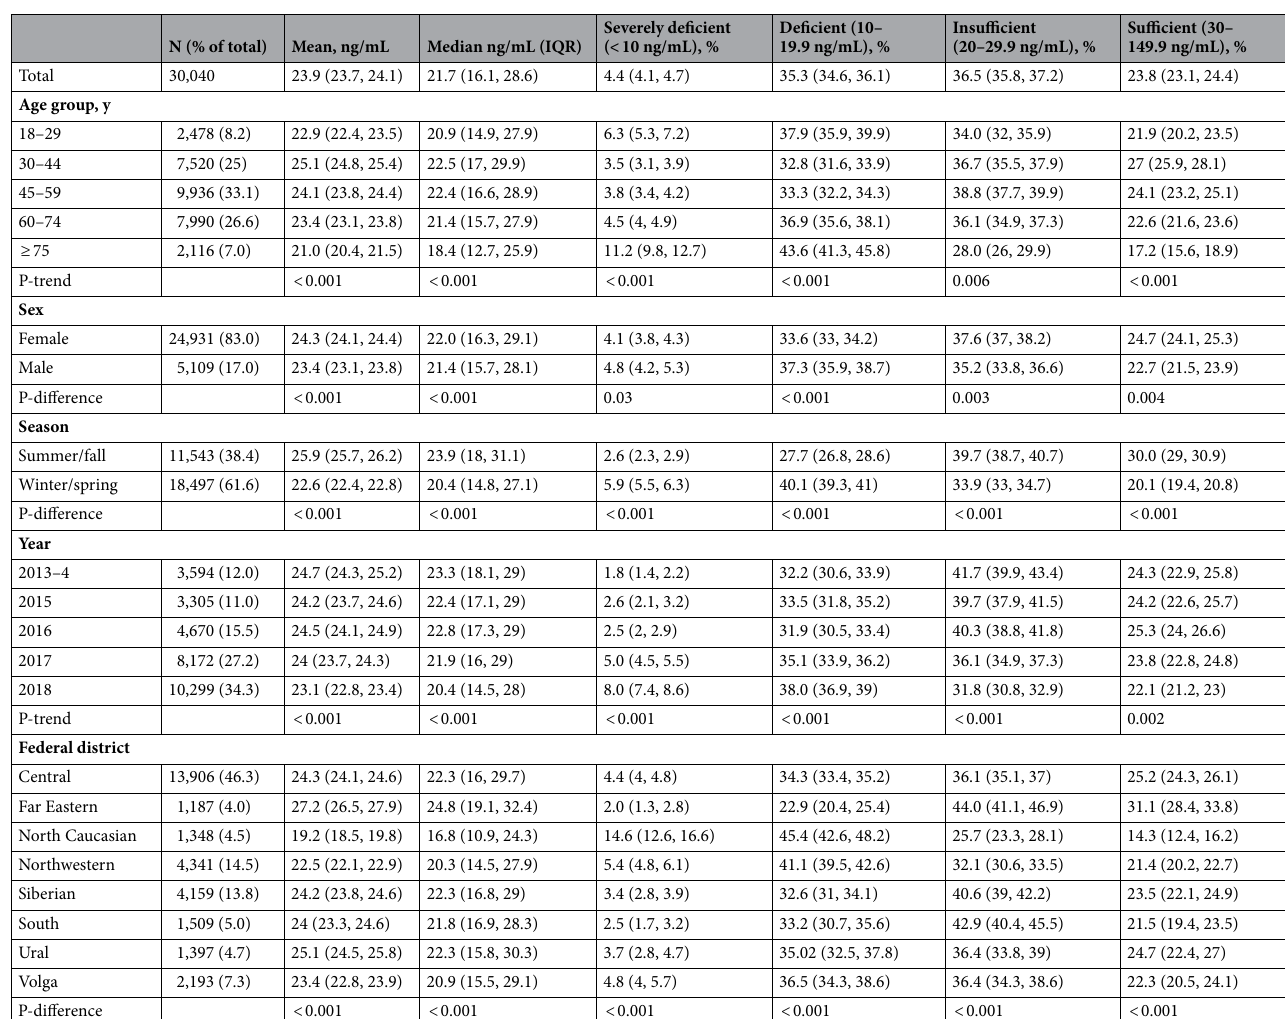
Table 1. Multivariable adjusted a mean 25(OH)D concentrations and status overall and by population sub- group in Russia (n = 30,040), 2013–2018. a Values represent age group, sex, season, year of data collection and federal district adjusted means, quantiles or proportions estimated via marginal values following linear regression, quantile regression and multinomial logistic regression for the mean, median and proportions, respectively. Values are fixed at the average level for the population under study apart from sex, which was weighted to represent the Russian population (53.7% female). Values in parentheses are 95% CI except for N and the median, which are the percent of the total sample and inter-quartile range, respectively. Data are from 2013 to 2018 and are from all months of the